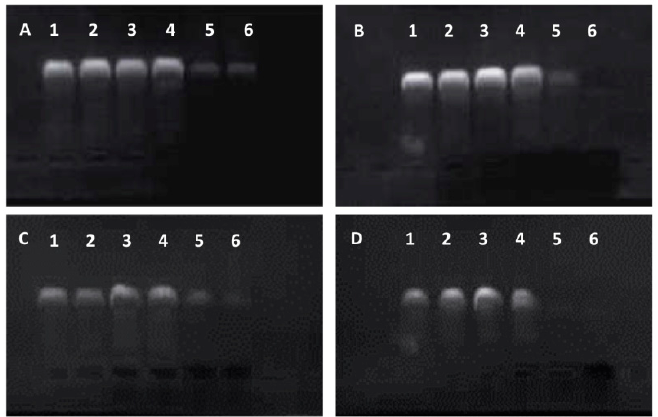
Figure 3. Electrophoretic mobility of f -MWCNTs: DNA complexes ( A : S1:DNA; B : S2:DNA; C : S3:DNA; D : S4:DNA). In all panels, lane 1 represents 0.3 µ g of free DNA. All other lanes contain f -MWCNTs complexes to 0.3 µ g of DNA at various charge ratios: lane 2, 1:1; lane 3, 2:1; lane 4, 4:1, lane 5,